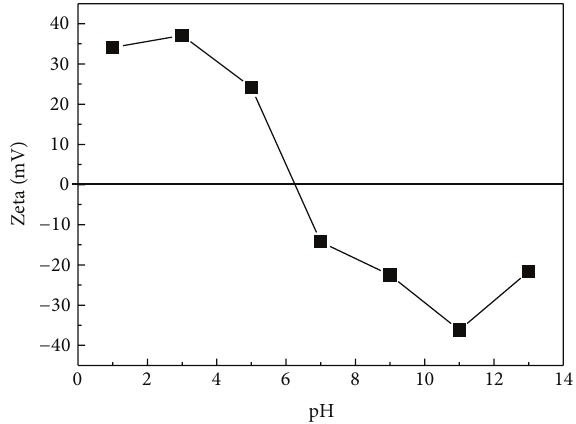
Figure 8: Zeta potential of N-doped TiO 2 powders in phenol aqueous solution at different pH values.